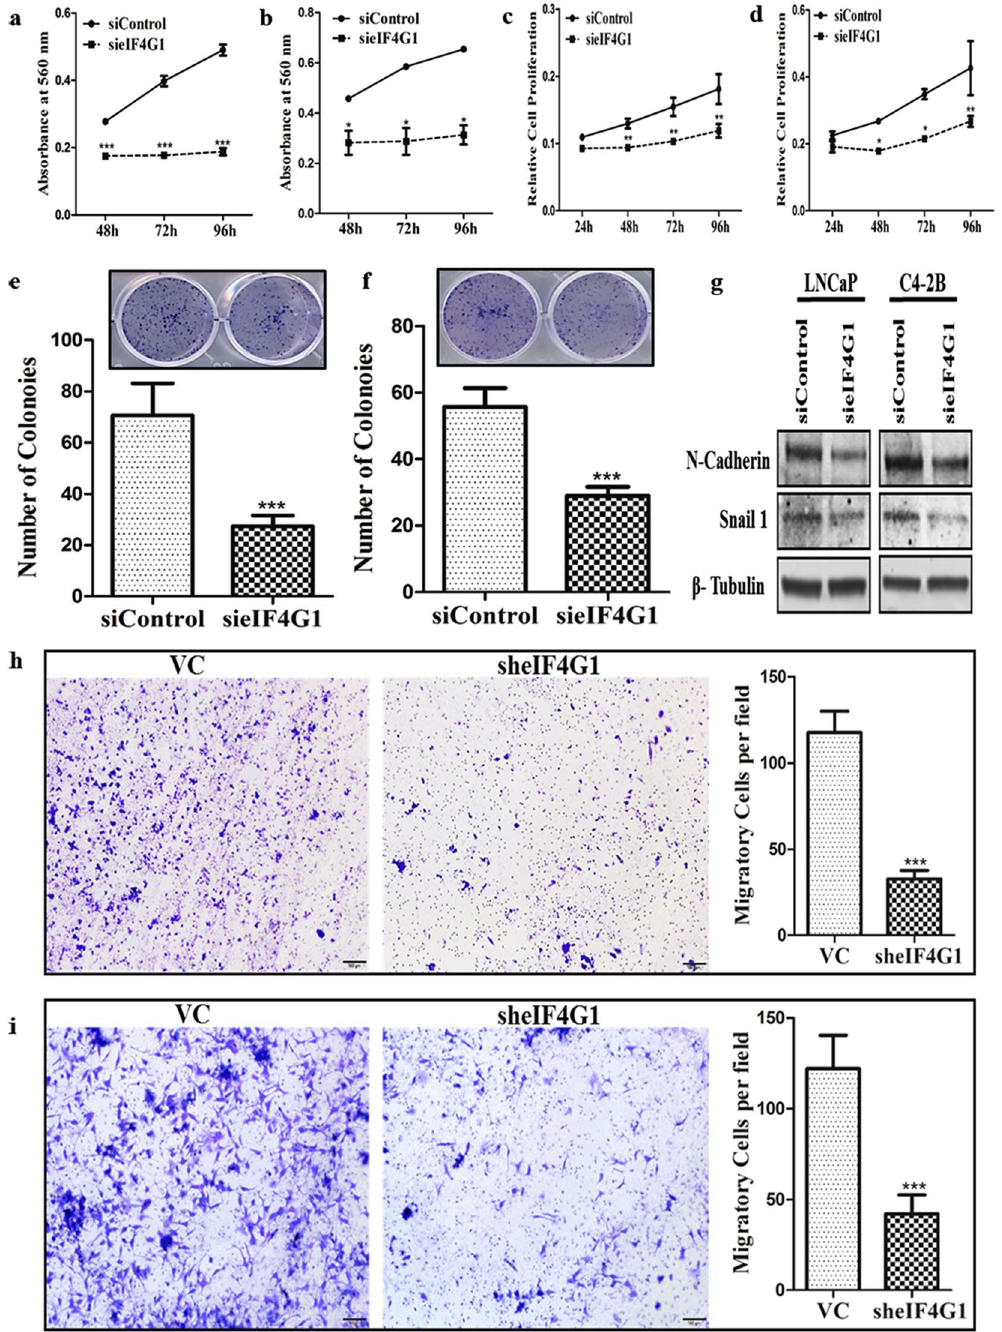
Figure 5. eIF4G1 is required for cell growth, colony formation, expression of EMT genes and cell migration in PCa Cells: Loss of Function studies following knockdown of eIF4G1 using siRNA ( a , b ). Cell viability was measured by crystal violet assay at 48–96 h with siControl and sieIF4G1, the graph showed absorbance at 560 nm for LNCaP ( a ) and C4-2B ( b ). ( c ) Cell proliferation assay for LNCaP and C4-2B ( d ) done by MTT assay at 24–96 h with siControl and sieIF4G1. ( e ) Colony formation for LNCaP and C4-2B ( f ) siControl and sieIF4G1, Lower panels: Colonies were counted using an ImageJ software. Error bar represents ± SD. ( g ) Representative image of immunoblotting for LNCaP and C4-2B for N-Cadherin & Snail 1 with siControl and sieIF4G1. ( h ) Representative image and graph of Transwell cell migration assays on LNCaP ( h ) & C4-2B ( i ) with Vector Control (VC) & sheIF4G1. p-values are indicated as * < 0.05, ** < 0.01, *** <